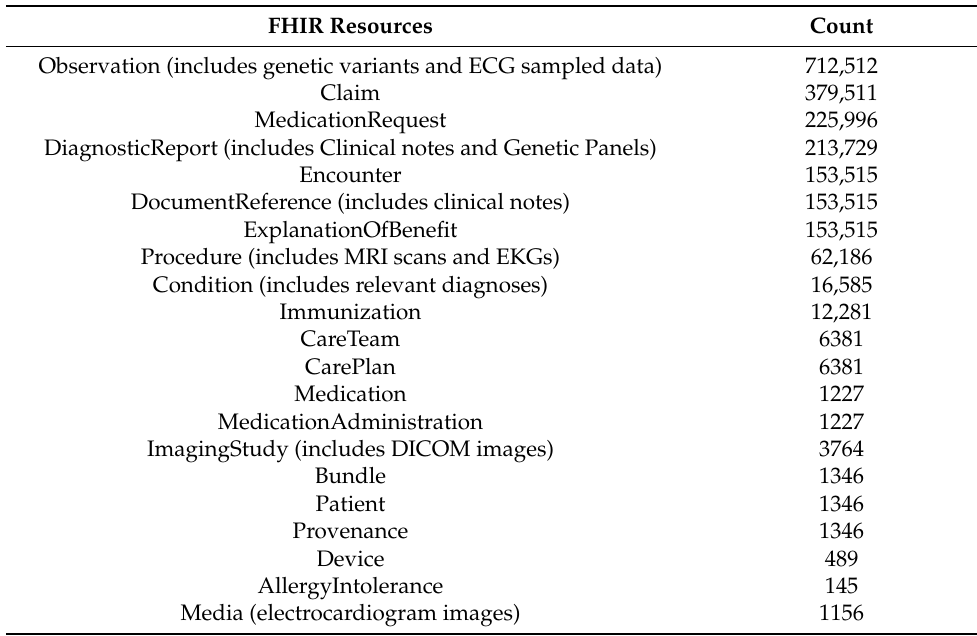
Table 3. Count of FHIR Resources utilized in the Coherent Data Set. FHIR